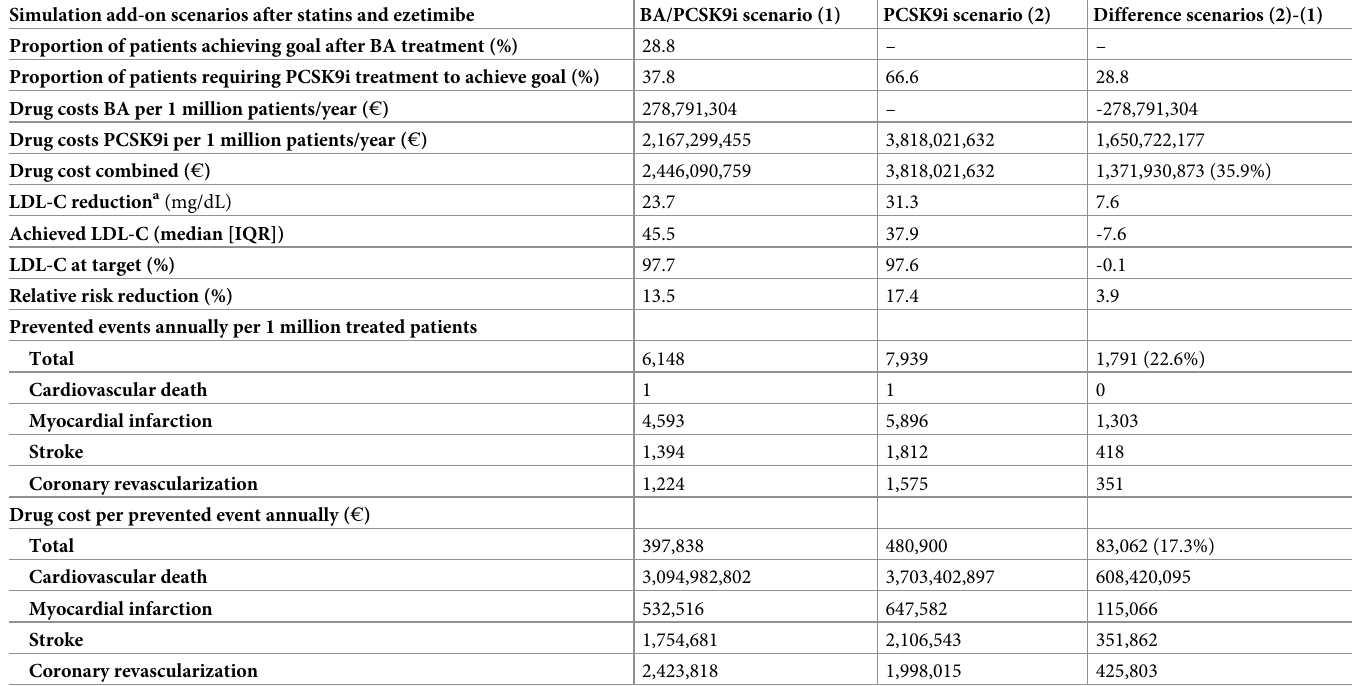
Table 2. Drug costs, prevented atherosclerotic cardiovascular disease events, and cost per prevented